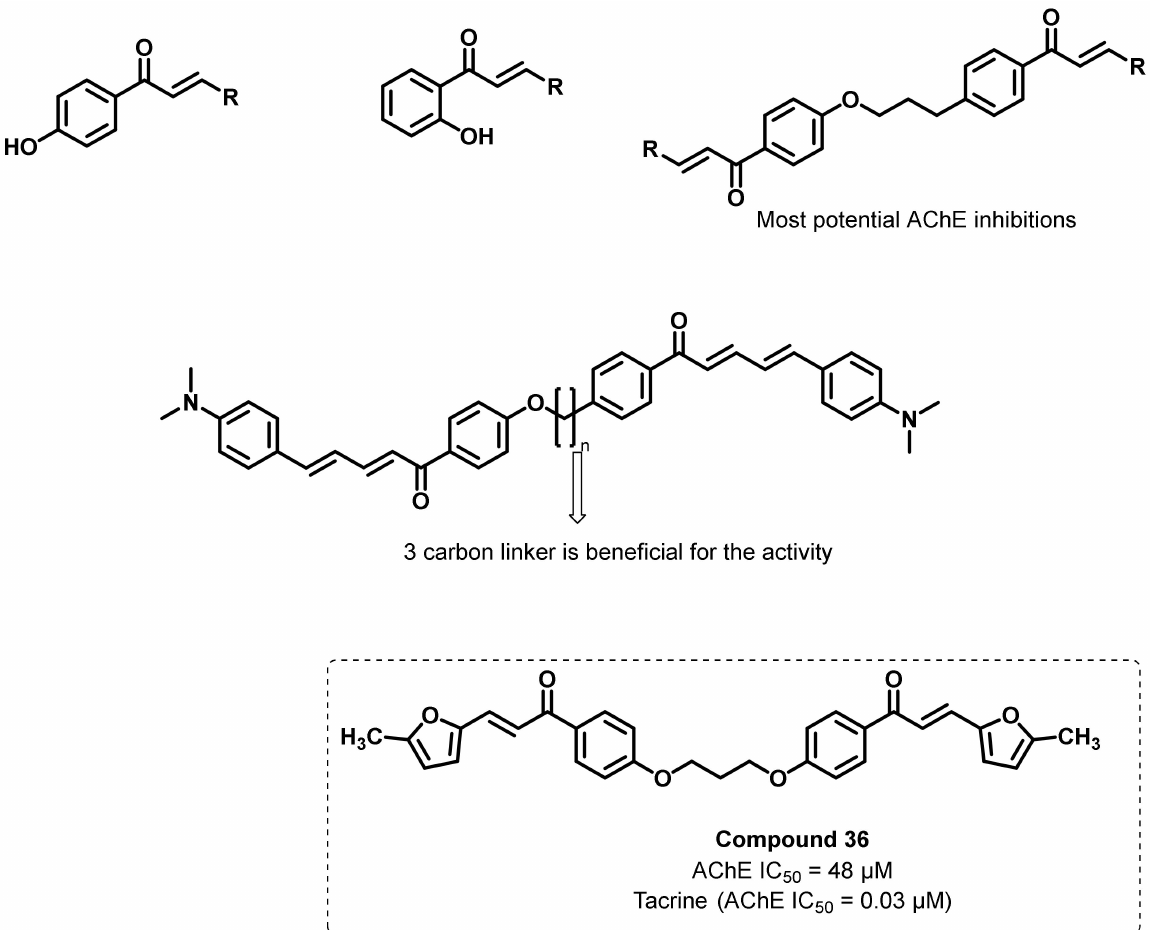
Figure 34. Chemical structure of bis-etherified